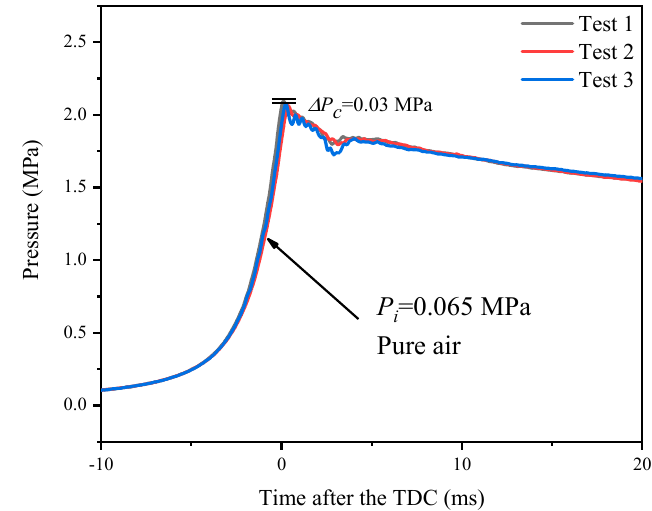
Figure 4. The stability of RCM experiments for pure air compression.